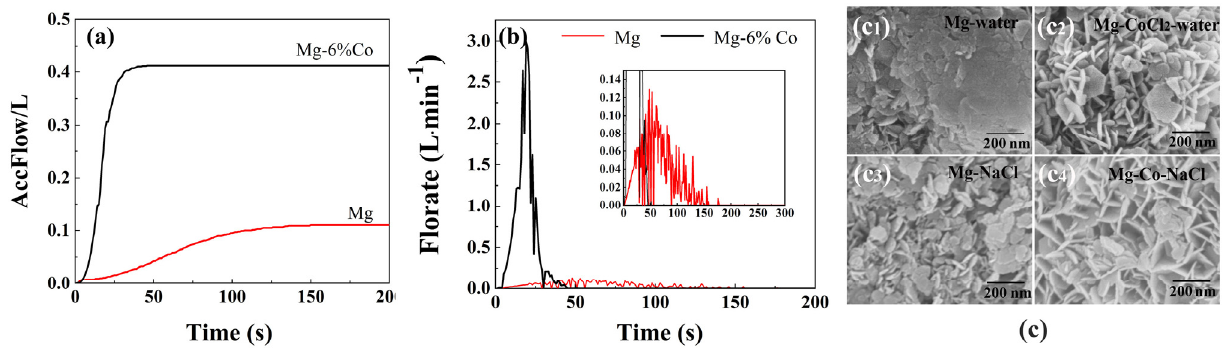
Figure 9. ( a ) Hydrogen generation curves of the Mg-6%Co with NaCl solute, ( b ) the hydrogen generation rate and ( c ) SEM images of reaction productions. Table 3. Hydrogen generation properties of ball-milled Mg-6%Co with water and NaCl solute.